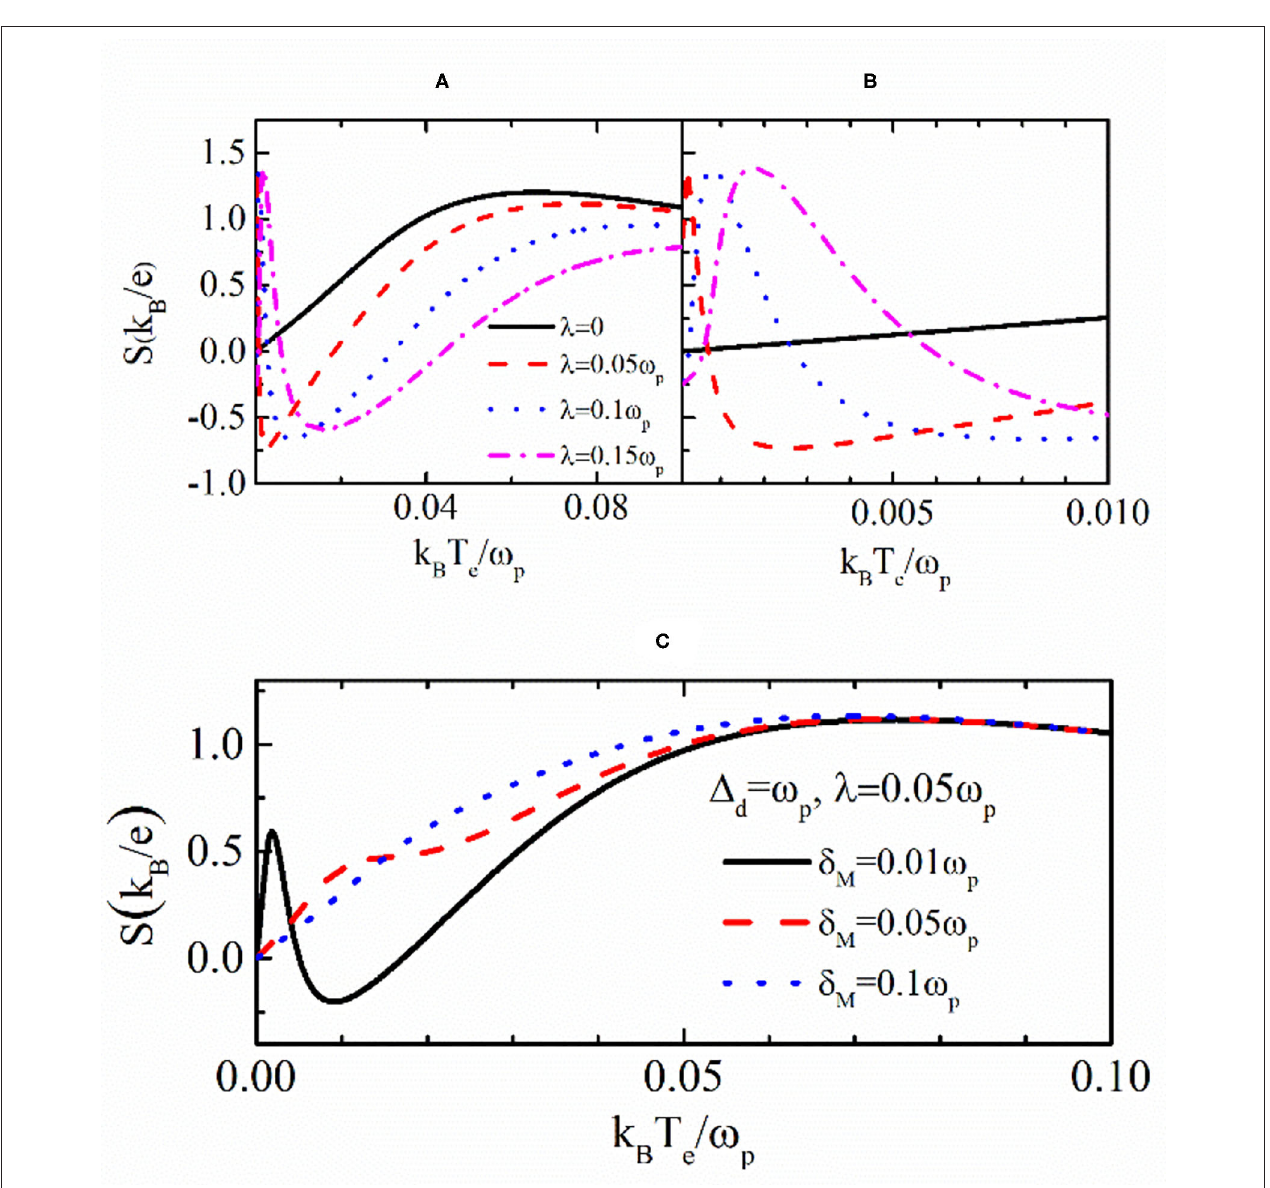
FIGURE 5 | Thermopower varying with the equilibrium temperature for ε d lower temperatures.